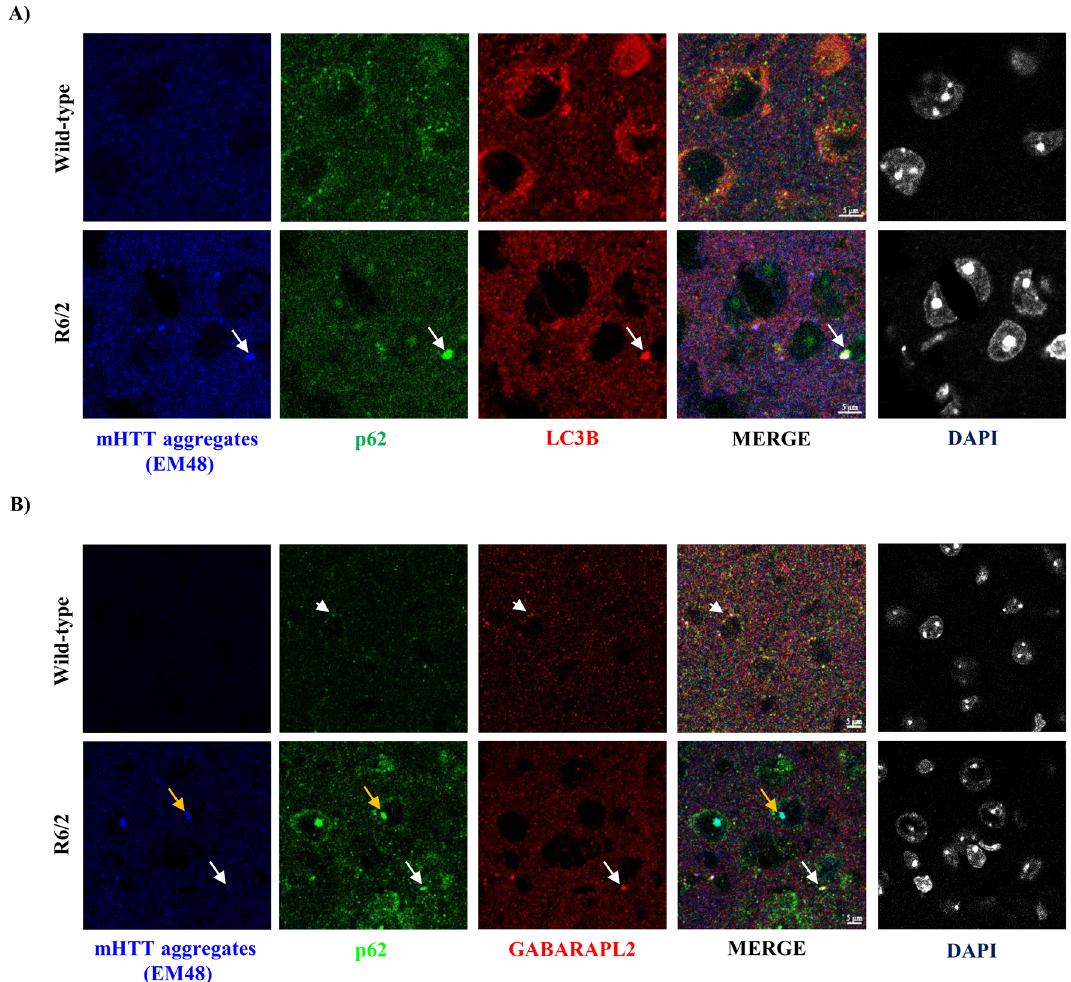
Figure 3. mHTT aggregates form intranuclear inclusions and get co-localised with p62/SQSTM1 in R6/2 in the striatum at 12 weeks. ( A ) Representative images for Immunohistochemistry for labelling of mHTT aggregates by EM48, and ATG proteins p62/SQSTM1, LC3B from wild-type and R6/2 mice. p62/SQSTM1 labelled in green, LC3B in red, and mHTT (EM48) in Blue. ( B ) Representative images for Immunohistochemistry for labelling of mHTT aggregates by EM48, and ATG proteins p62/SQSTM1, and GABARAPL2 from wild-type and R6/2 mice. p62/SQSTM1 labelled in green, GABARAPL2 in red, and mHTT (EM48) in Blue. Magnification = 63X. Scale bar = 5 μm. N = 3. White arrow indicates co-localisation of mHTT (EM48) aggregates with ATG markers. White arrowheads indicate co-localisation of p62/SQSTM1 with GABARAPL2. Yellow arrows indicate co-localisation of mHTT (EM48) aggregates with p62/SQSTM1. N = number of